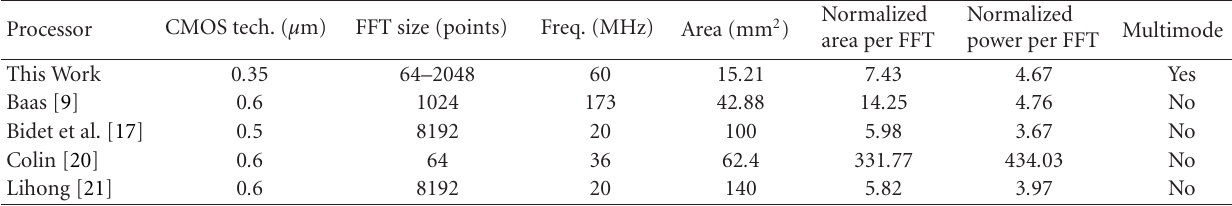
Table 5: Comparison of various FFT/IFFT